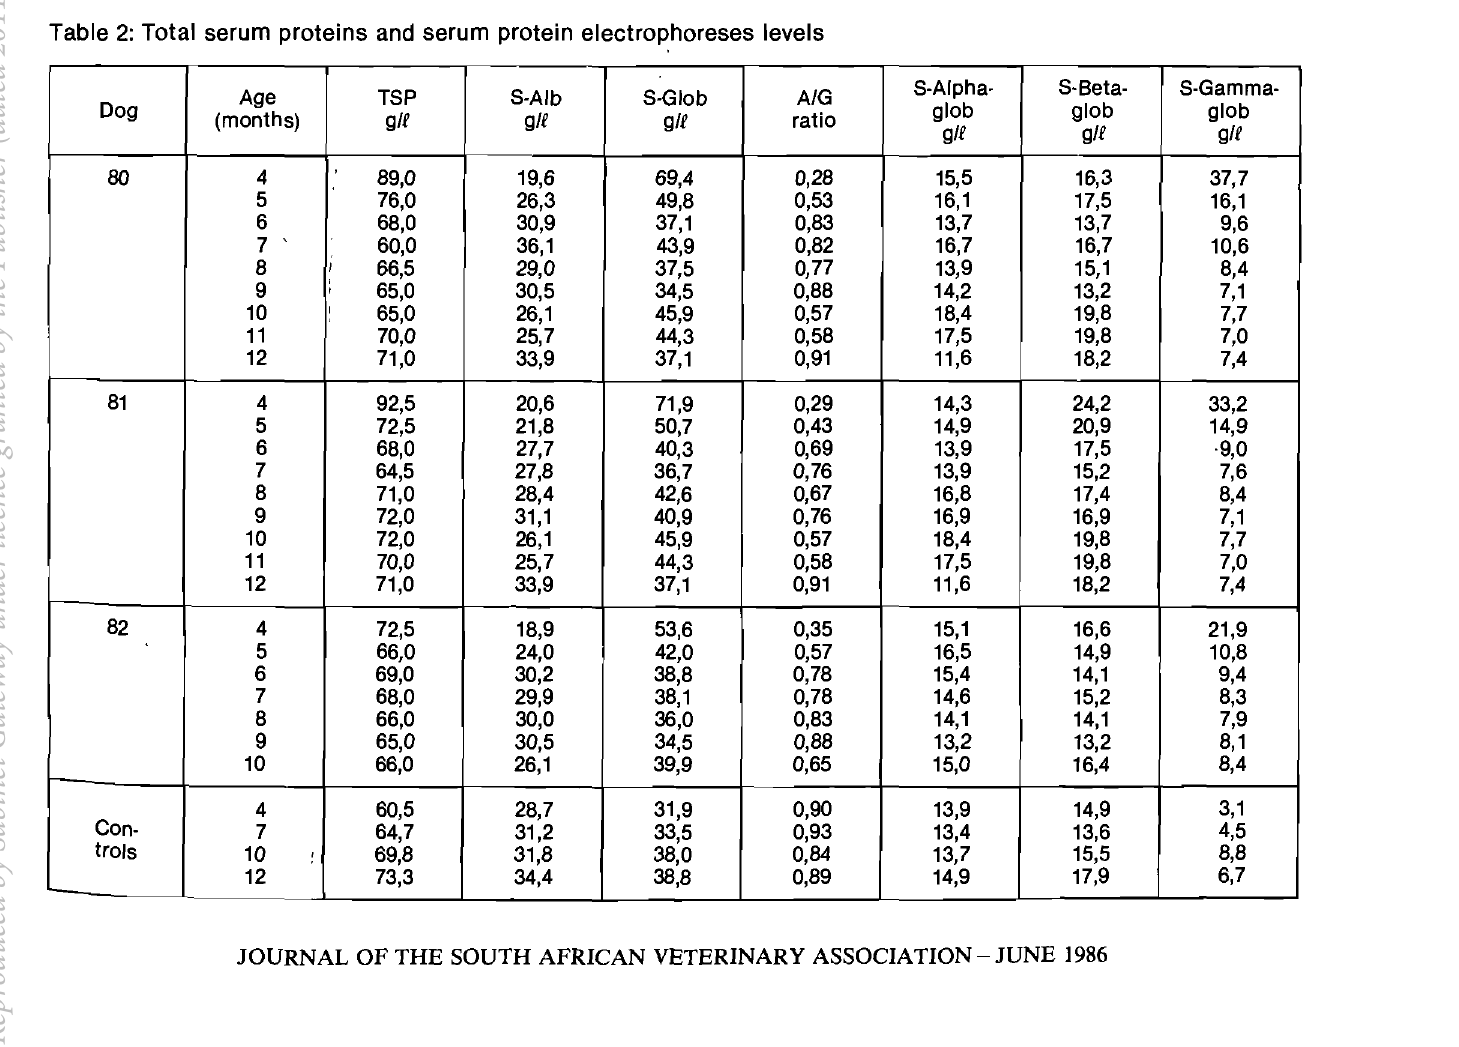
Table 2: Total serum proteins and serum protein electrophoreses